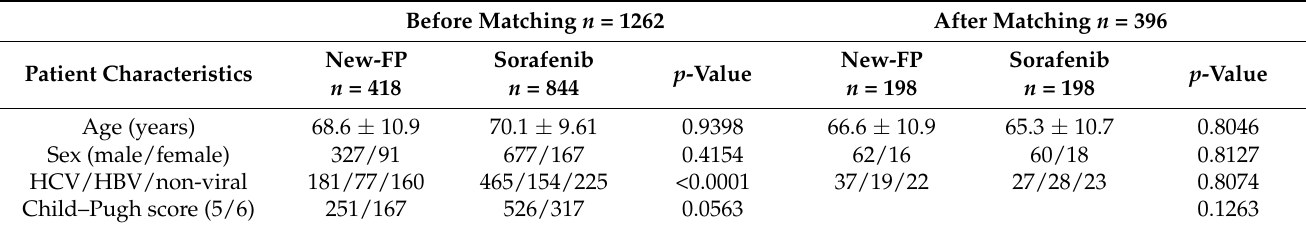
Table 1. Patient characteristics before and after propensity score